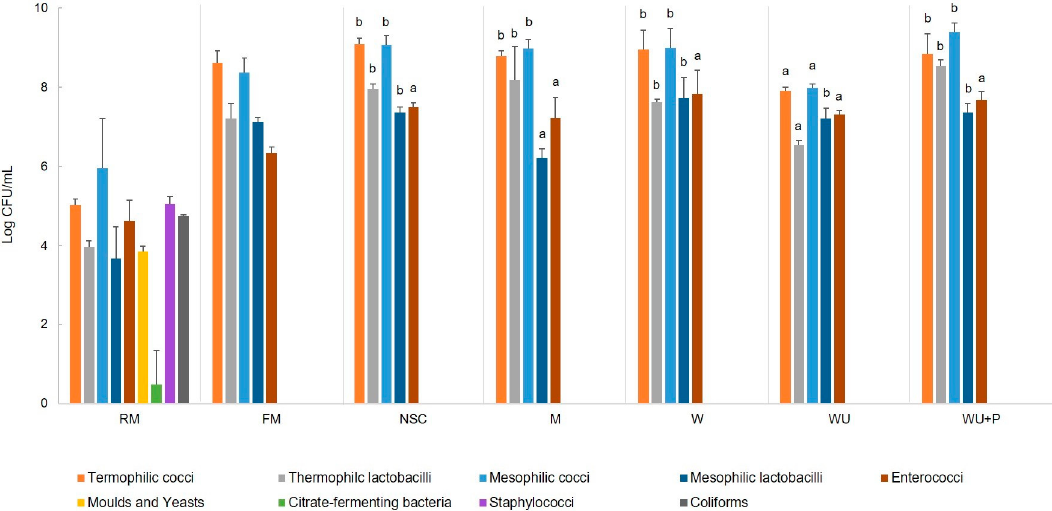
Figure 2. Microbial counts of thermophilic cocci and lactobacilli, mesophilic cocci and lactobacilli, enterococci, moulds and yeasts, citrate-fermenting bacteria, staphylococci, and coliforms in raw ewe milk (RM), fermented milk (FM), a natural starter culture (NSC), an NSC grown in ewe’s milk (M), whey (W), whey ultrafiltered (WU), and in whey ultrafiltered and supplemented with bacteriological peptone (WU + P). Microbial counts were expressed as Log CFU/mL ± standard deviation. For each microbial group detected in NSC, and NSC grown in M, W, WU, and WU + P, different letters above the respective column indicate significant ( P < 0.05) differences in the Log CFU/mL, according to the Tukey–Kramer post hoc test.